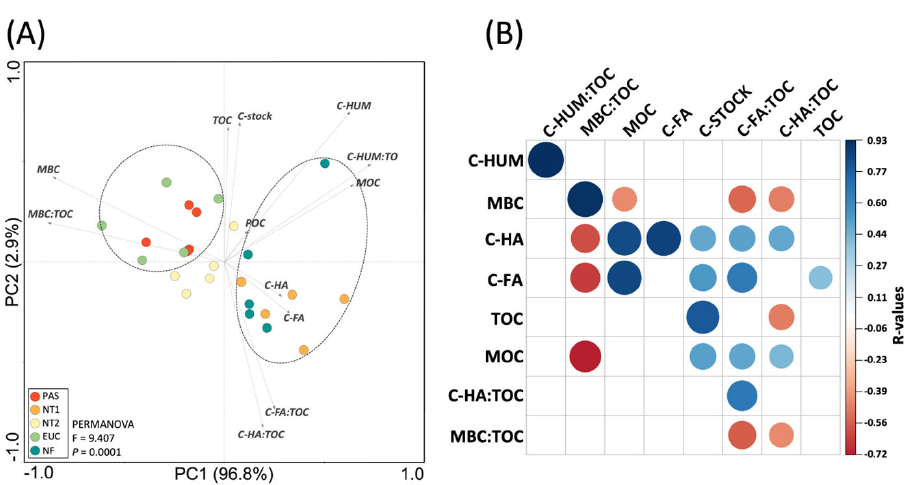
Figure 5. ( A ) Principal component analysis biplot comparing the structure of SOC fractions among treatments. The dashed lines in the graph indicate significant clusters (PERMANOVA, p < 0.05). ( B ) Heatmap showing the Spearman’s rank correlation coefficients and statistical significance between SOC fractions. Blue and red colors indicate significant positive and negative correlations, respectively ( p <